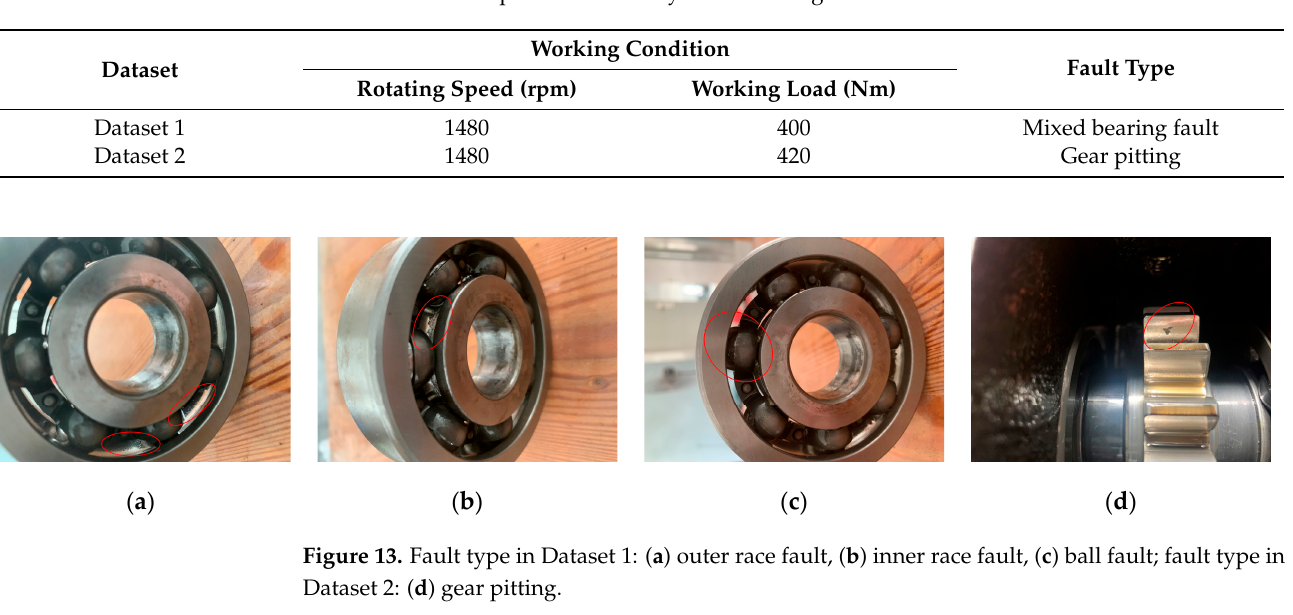
( d ) Figure 14. Waterfall plots of sub-band features and corresponding MCHs for signals: ( a ) sub-band features of Dataset 1, ( b ) MCHs of Dataset 1, ( c ) sub-band features of Dataset 2, ( d ) MCHs of Dataset 2.